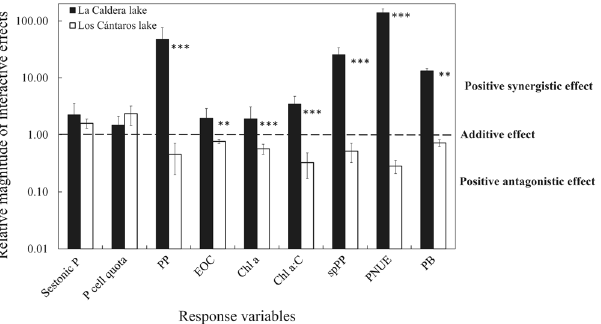
Figure 5. Nature and magnitude of the observed interactive impacts of UVR, and nutrient enrichment. Sestonic P, P cell quota, primary production (PP), excretion of organic carbon (EOC), Chlorophyll a (Chl a), specific cell productivity (spPP), photosynthetic nutrient-use efficiency (PNUE), and phytoplanktonic biomass (PB) (more details in Table